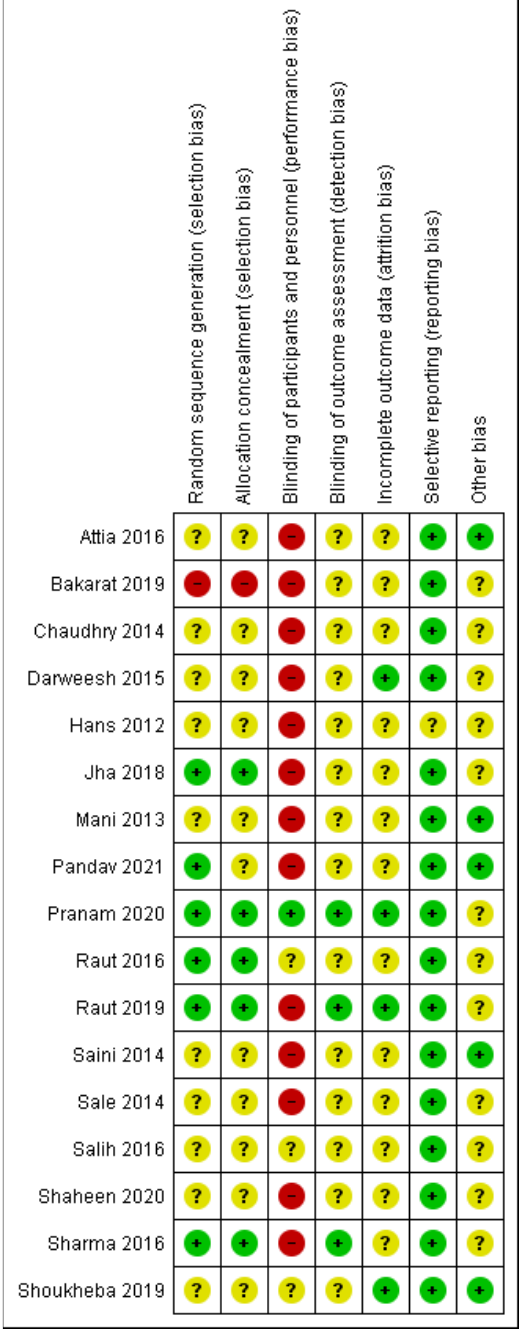
Figure 2. Summary of risk of bias analysis: review authors’ judgment about the different domains for each included study. A green circle (+) indicates a low risk of bias, a yellow circle (?) an unclear risk of bias, and a red circle ( − ) a high risk of bias in the respective domain. As potential other sources of bias, the following were considered: potential group differences regarding diabetes, smoking habits, and mouthwashes.